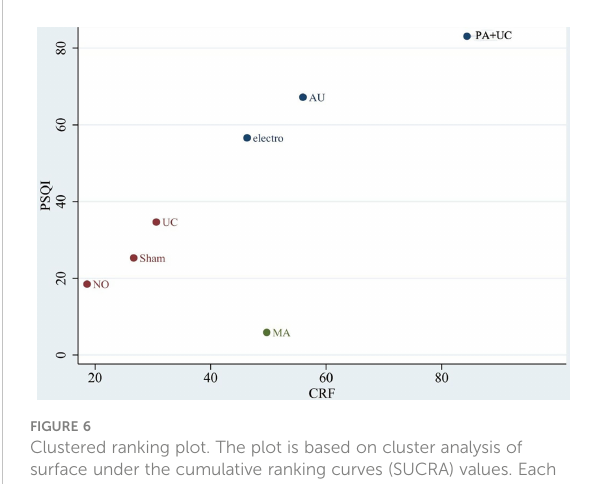
FIGURE 6 Clustered ranking plot. The plot is based on cluster analysis of surface under the cumulative ranking curves (SUCRA) values. Each plot shows the SUCRA values for two outcomes CFS: Cancer Fatigue Scale (CFS) and Pittsburgh Sleep Quality Index